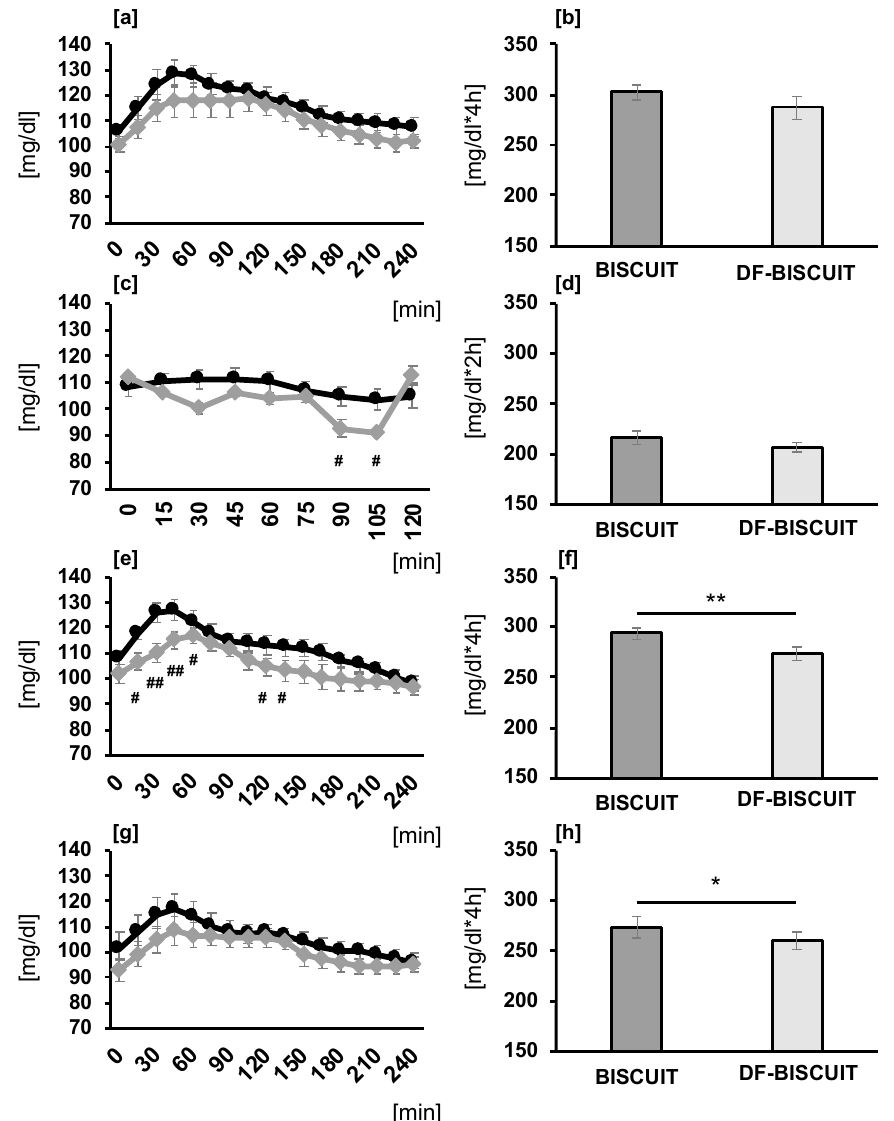
Figure 3. Concentrations of glucose and areas under the curve (AUCs) of lunch ( a , b ), snacks ( c , d ), dinner ( e , f ), and breakfast ( g , h ) in the BISCUIT trial and DF-BISCUIT treatment. Data represent the mean ± standard errors. # p < 0.05, ## p < 0.01 compared with level in the BISCUIT trial (Bonferroni test for post hoc); * p < 0.05, ** p < 0.01 compared with level in the BISCUIT trial (paired t -test). BISCUIT, regular snack; DF-BISCUIT, snacks with a rich dietary fiber content.